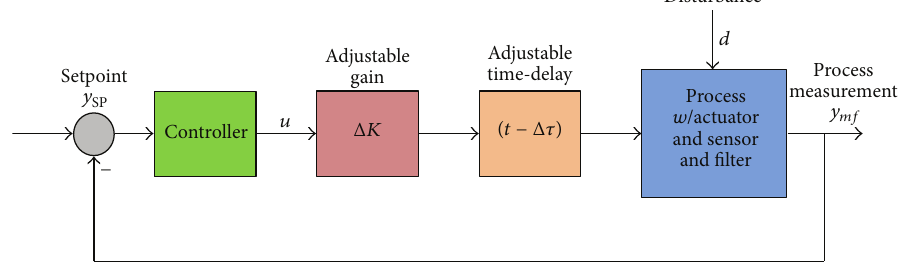
Figure 6: An adjustable gain and time-delay are inserted into the loop to find the stability margins (gain margin and phase margin)